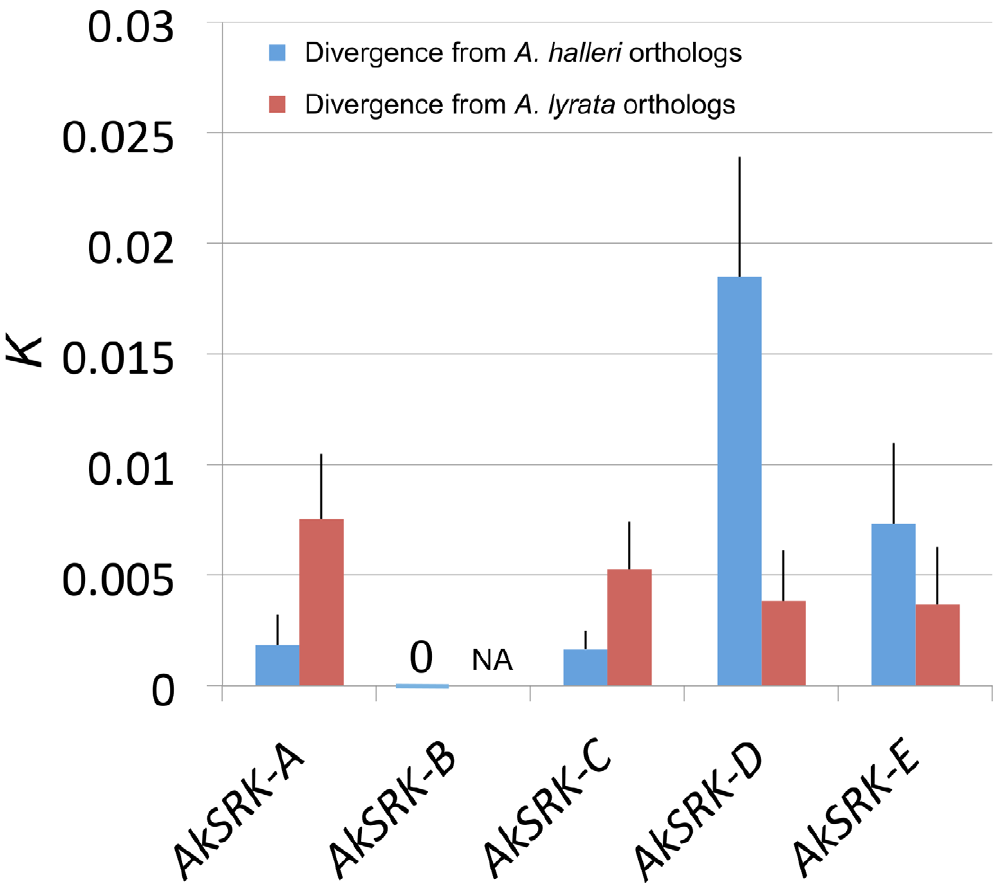
Figure 2. Nucleotide divergence of AkSRK of five S -haplogroups in A.kamchatica from two parental species. All estimates were Jukes– Cantor corrected. Bars indicate standard errors. Sequence lengths compared were: 935 bp ( AkSRK-A ), 3773 bp ( AkSRK-B ), 1067 bp ( AkSRK-C ), 555 bp ( AkSRK-D ) and 550 bp ( AkSRK-E ). AkSRK-B was 100% identical to AhSRK-B throughout the coding sequence (see also Figure 5). Because AkSRK-B belongs to a newly identified S -haplogroup (see Results), orthologous sequences were not yet reported from A. lyrata , while AhSRK-B from A.